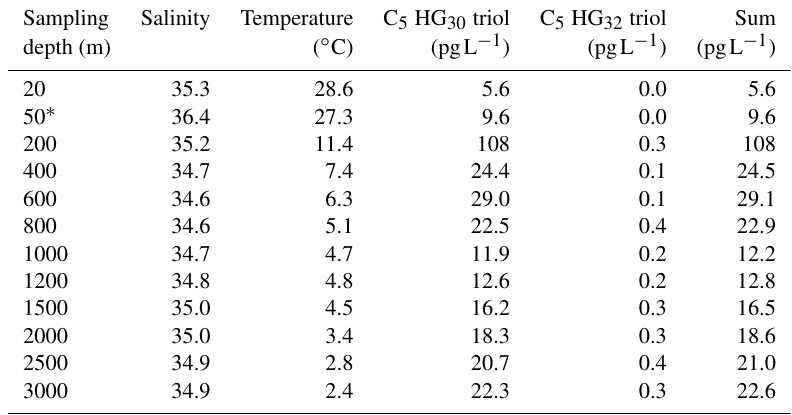
Table 2. The additional SPM samples collected for high-resolution depth profile at Station 10 (0.3µm GF75 filters). Sampling Salinity